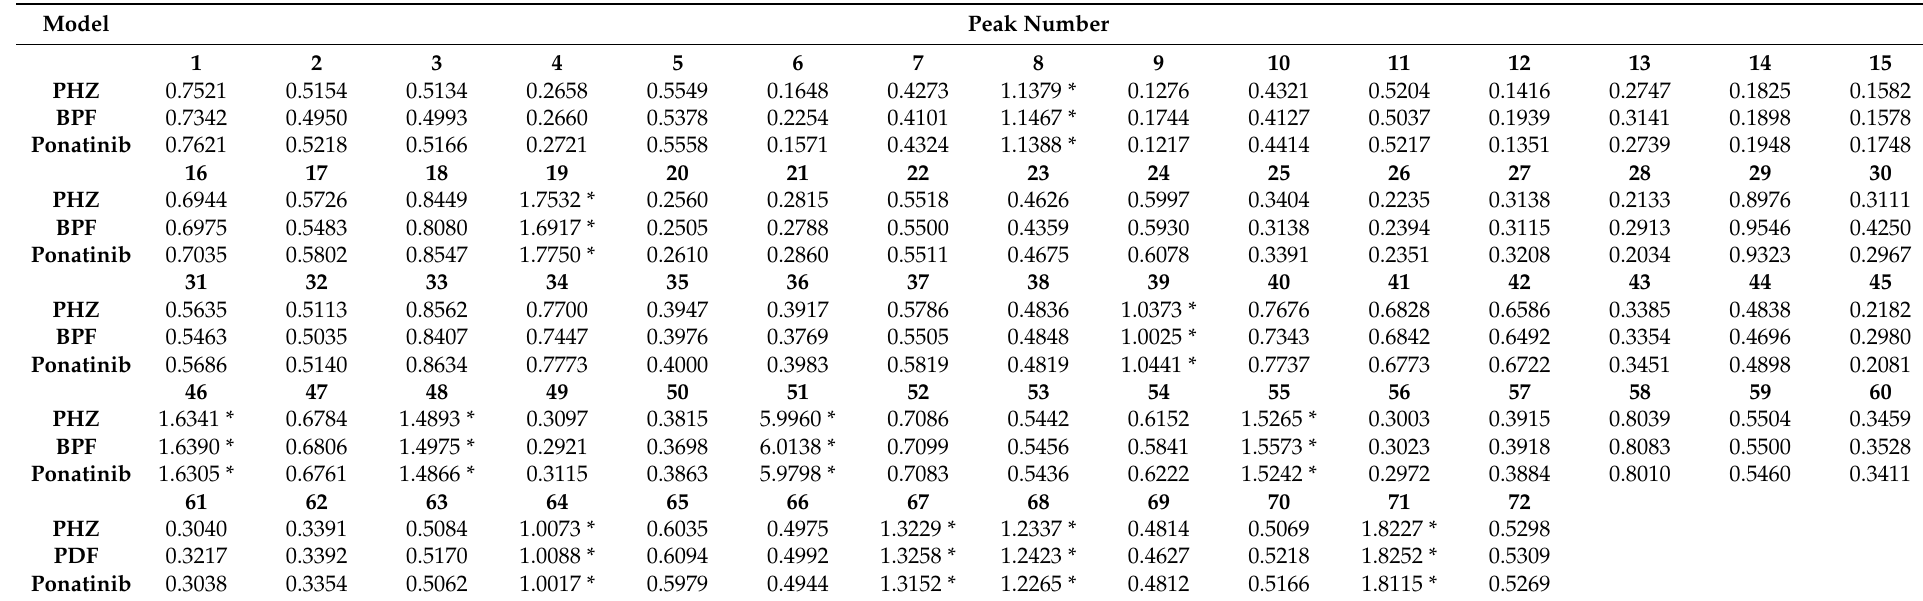
Table 3. Summary of the VIP values of the components in the DH herbal pair in three zebrafish